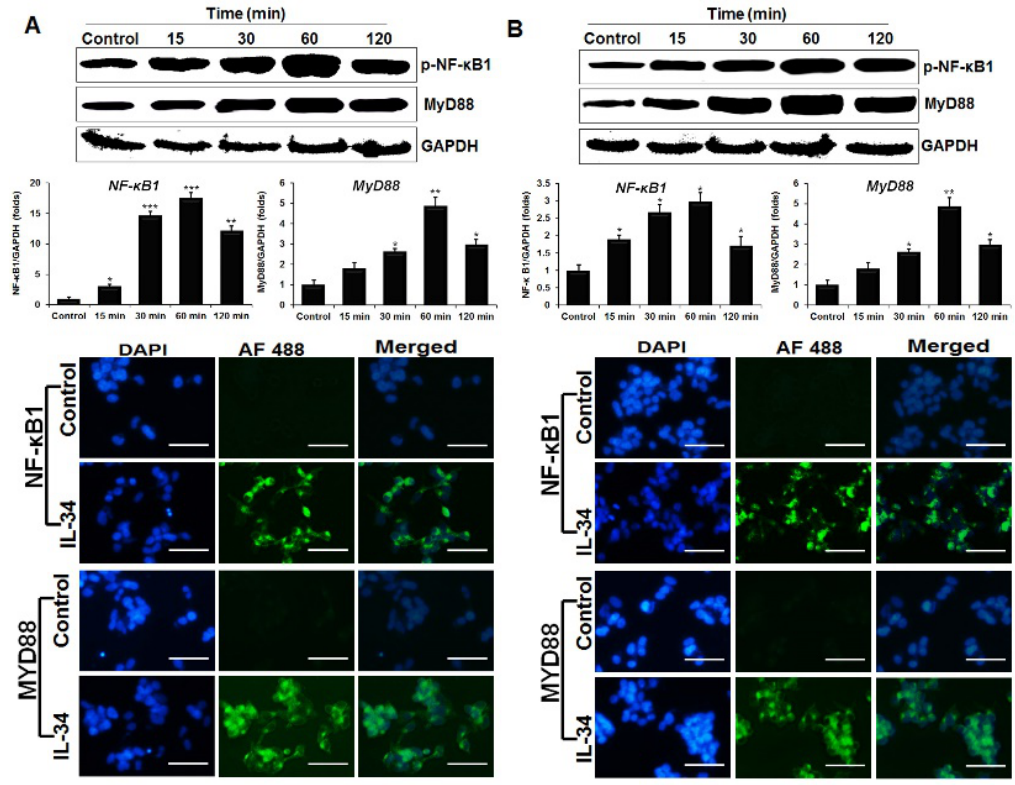
Figure 4. IL-34 induces phosphorylation of NF- κ B1 and MyD88. The HD11 ( A ) and OU2 ( B ) cell lines were treated with or without IL-34 for 15, 30, 60, and 120 min. Total lysates were analyzed by western blot with antibodies against p-NF- κ B1 and MyD88 (top). The changes in the levels of mRNA for NFKB1 and MYD88 in cells treated with or without chIL-34 were measured by qRT-PCR and levels were normalized to those of GAPDH (middle). Data are presented as the mean ± SEM ( n = 3) of 3 independent experiments: * p < 0.05, ** p < 0.01, and *** p < 0.001. Immunocytochemical analysis of p-NF- κ B1 and MyD88 signaling proteins in HD11 (left) and OU2 (right) cells. Both untreated cells and those treated with chIL-34 were incubated with primary antibody, Alexa Fluor ® 488-conjugated goat anti-rabbit IgG (H + L) secondary antibody and DAPI (blue). Scale bar represents 25 µm.